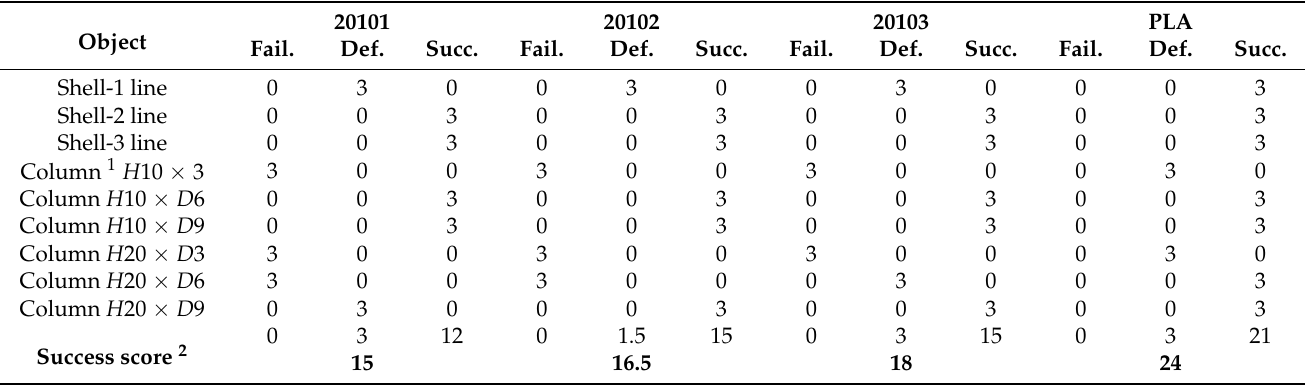
Table 3. Results after qualitative visual observation of thin shells and columns, with each object categorized as “Failed” (Fail.), “Deformed” (Def.) and “Successful”